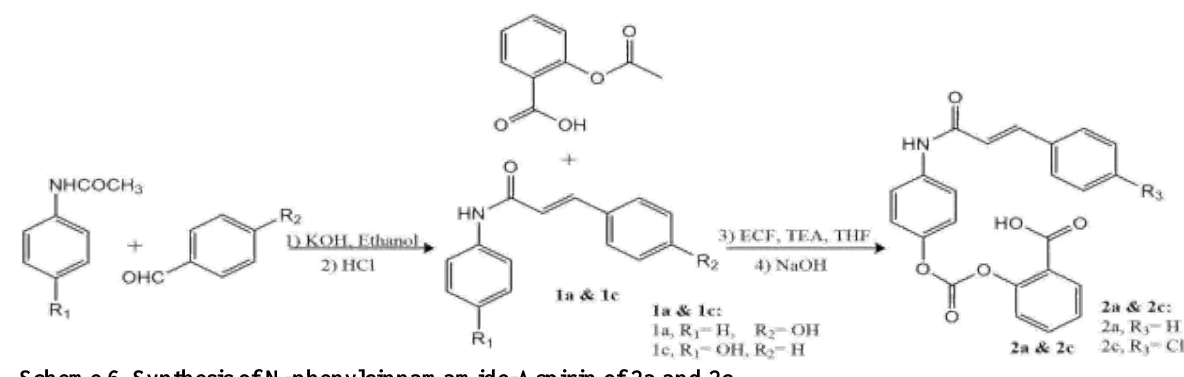
Table (2) Results on the antibacterial and antifungal of N-phenylcinnamamide-Aspirin (2a & 2c). Compounds Antibacterial Anti-fungal E.